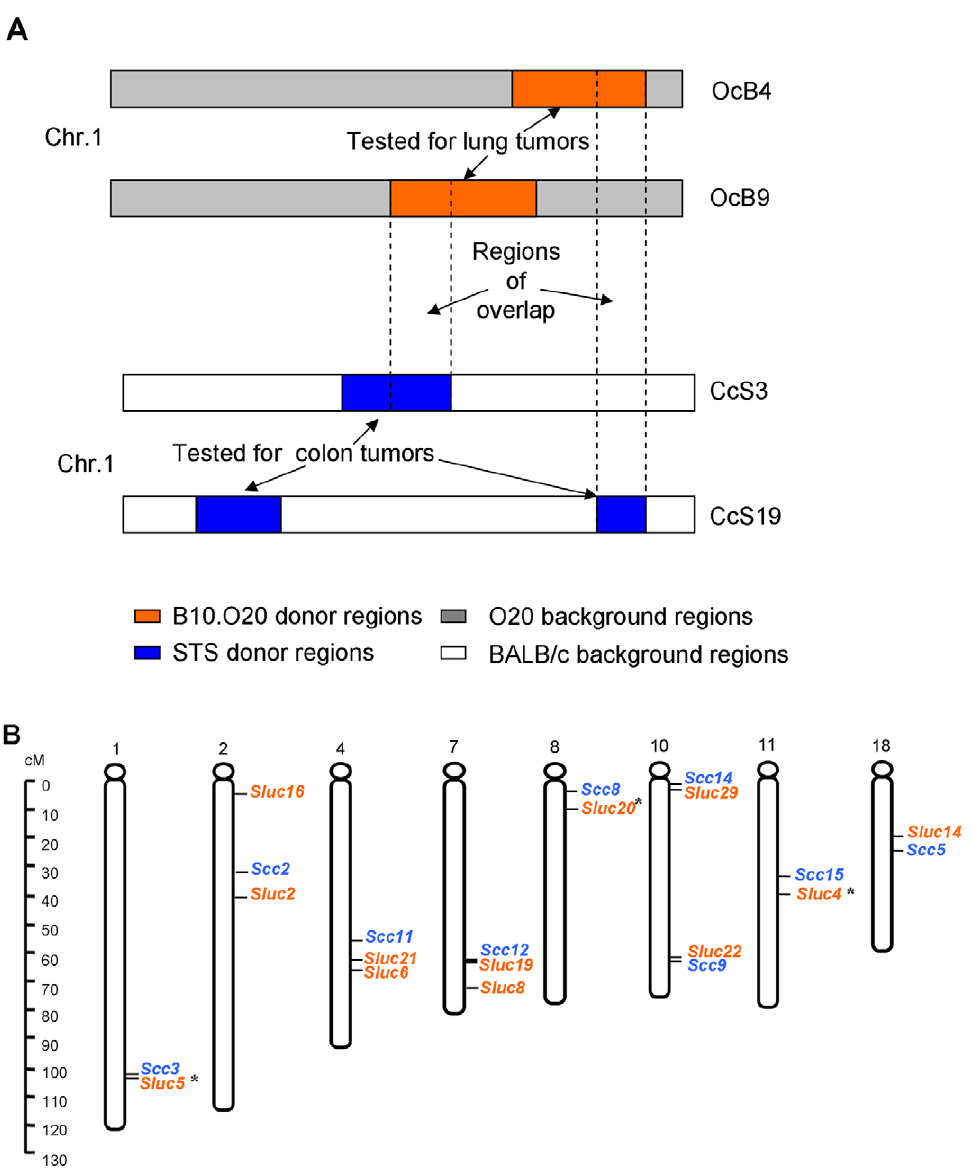
Figure 5. Co-localization between Sluc loci mapped in the OcB RC strains and Scc loci mapped in the CcS RC strains. A . Schematic representation of overlapping donor chromosomal regions between the CcS and OcB RC strains (regions tested for both colon and lung cancer susceptibility loci). Such regions are informative and we used them to test whether Sluc and Scc loci are more frequently located together in the same donor chromosomal region. Part of a chromosome is shown as example. B . Frequent co-localization between Sluc and Scc loci identified independently in OcB and CcS RC strains, respectively (See also Table 1 for detailed locations). *Map locations of these Sluc loci are slightly different from the locations of the same loci shown in Figure 4, since they are mapped in different RC strains using different microsatellite